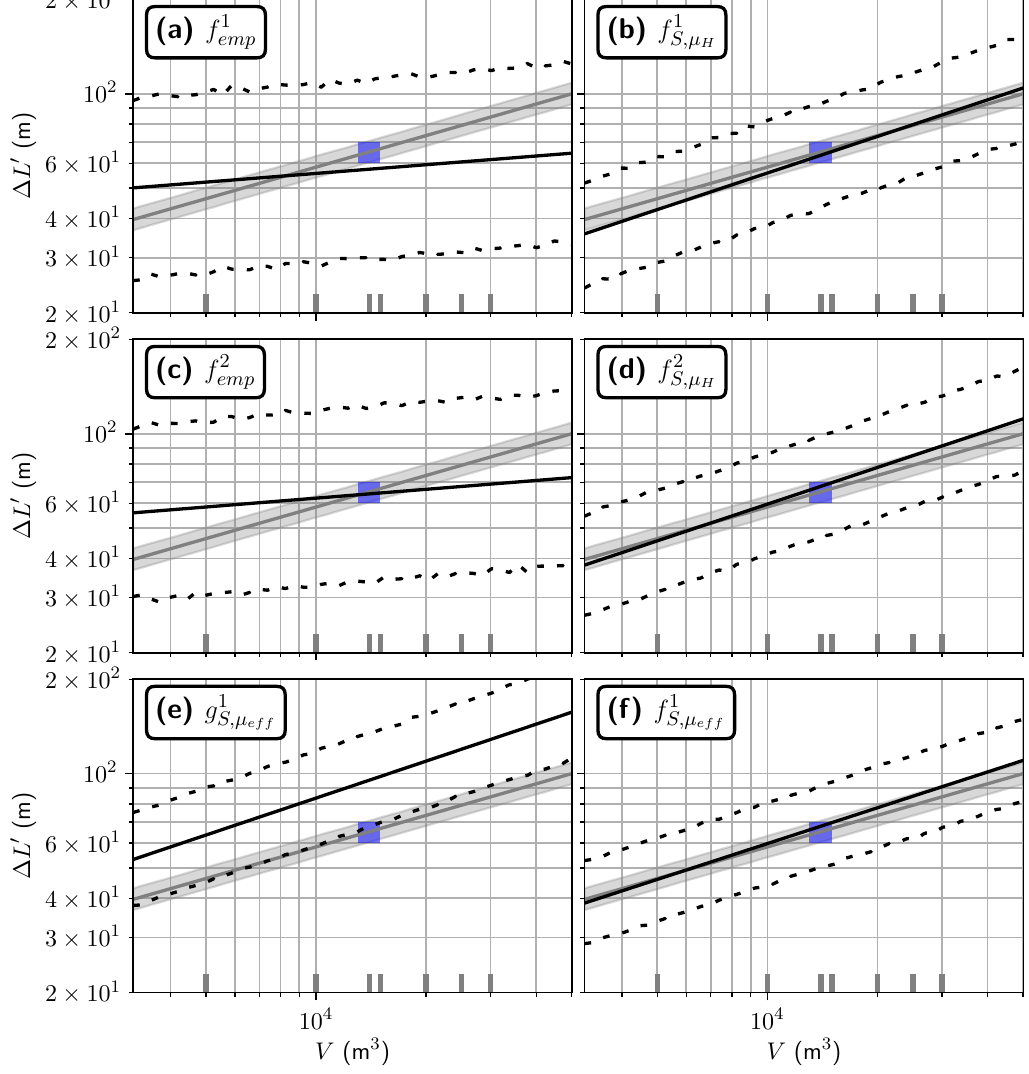
Figure 10. Travel distance estimated from volume for the Fei Tsui Road case study. Blue rectangle: estimations of volumes and travel distances for 1903 slide the documented event. ( a – f ), and symbols are the same as for Figure